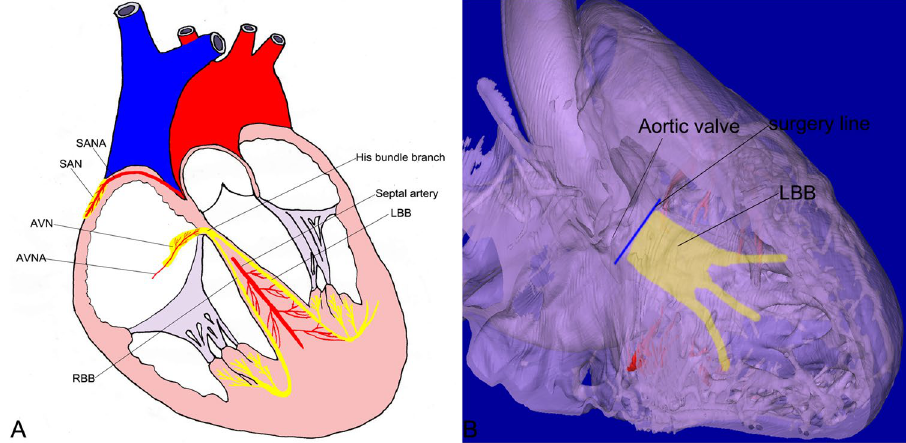
Figure 5. Diagram and illustration. ( A ) Diagram of the cardiac conduction system (CCS) and its nutritious arteries. ( B ) The 3D model illustrates that, during some surgeries, surgeons should pay attention to the location of the LBB and its nutritious arteries. In TAVI, surgeons cannot put the aortic prosthesis over the surgery line (in